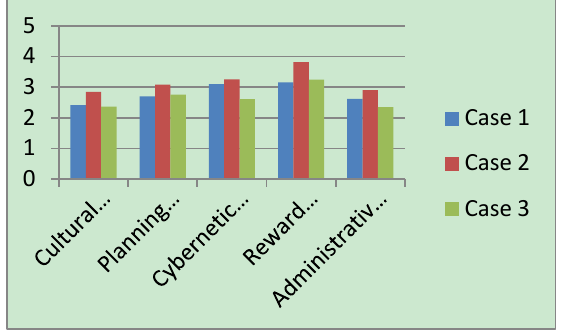
Figure 4. Amount of challenge for reflection—organization